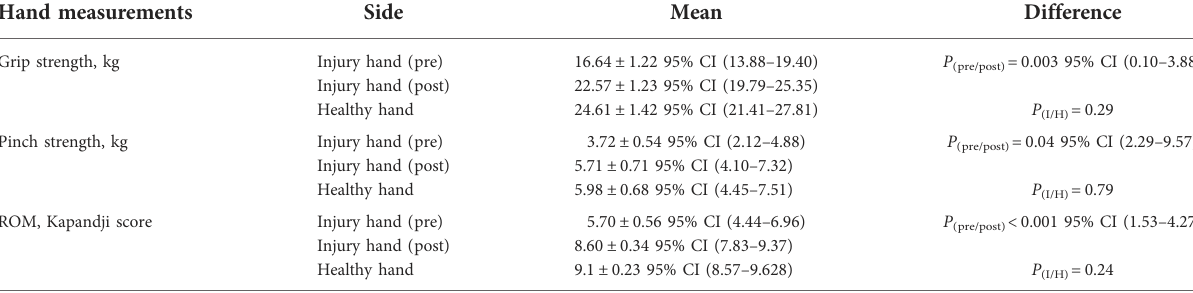
TABLE 2 Comparison of objective outcomes in the preoperative period and 1-year follow-up.